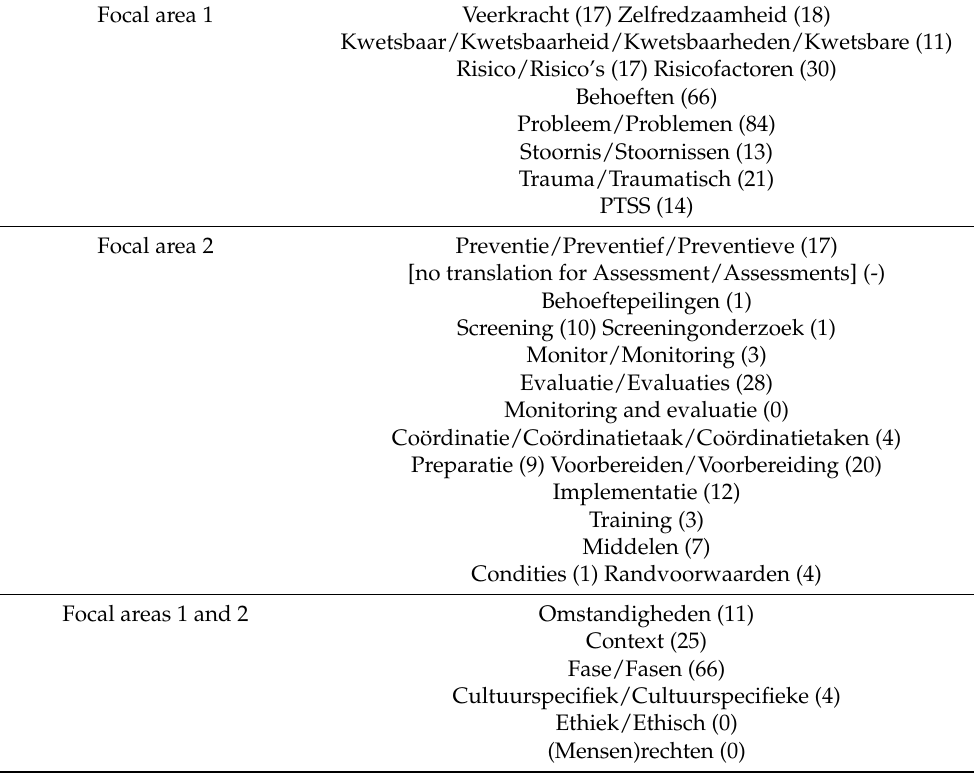
Table A1. Dutch version of terminology used to fill Table